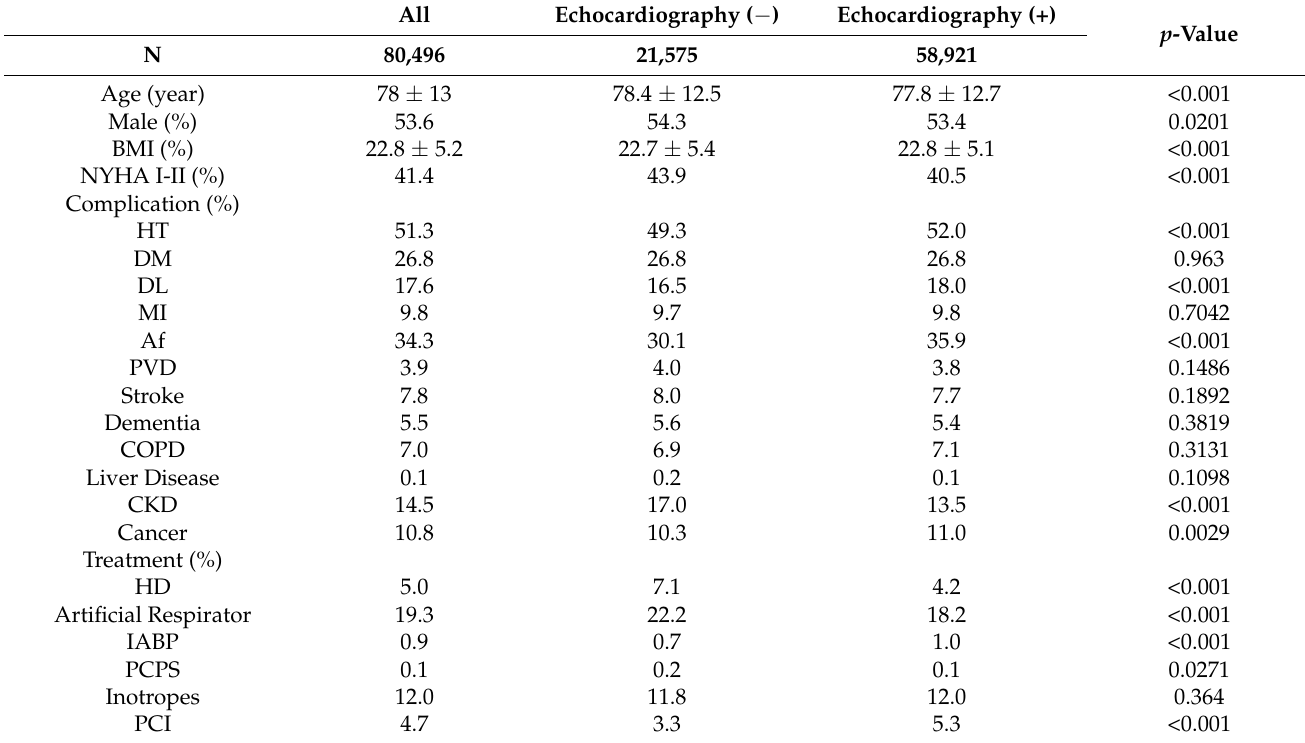
Table 2. Characteristics with and without